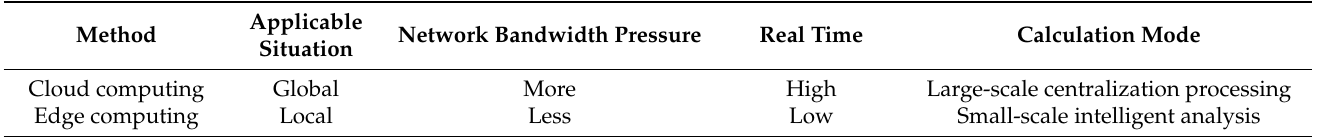
Table 1. Main differences between cloud computing and edge